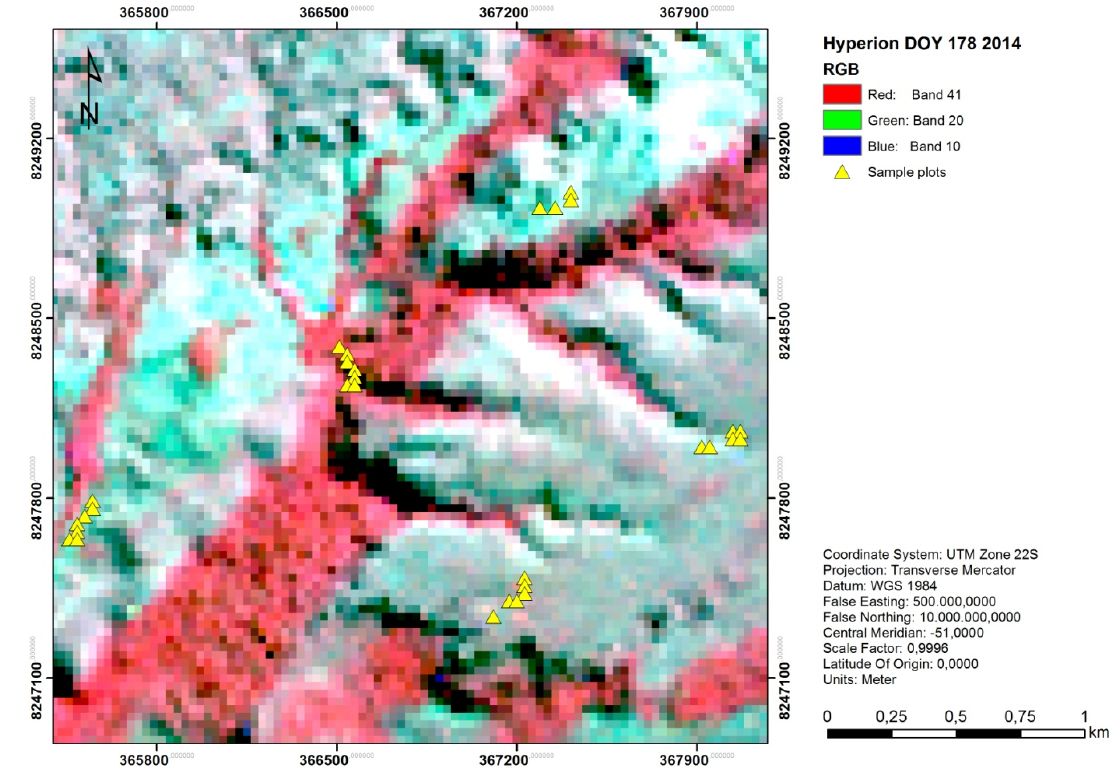
Figure 2. False colour RGB composite of the spectral.image predictor map: a subset of the hyperspectral Hyperion image covering an area of natural vegetation in the Brazilian Cerrado, acquired on 27 June 2014 (DOY 178). The overlaid yellow triangles represent the sample locations, for which both the biological ( trees ) and predictor ( spectra ) datasets were derived.